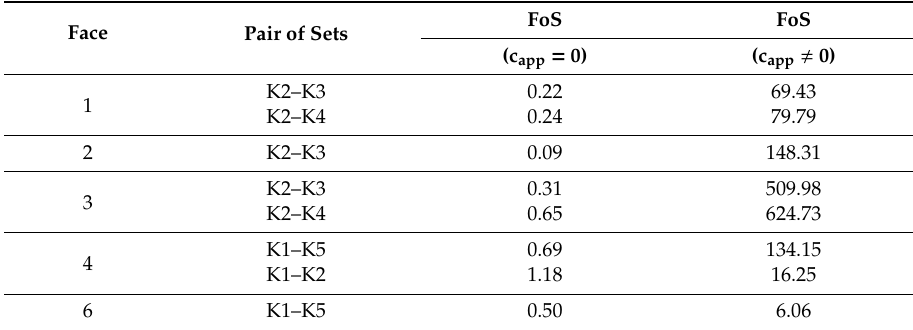
Table 10. FoS values obtained considering the presence of seismic action with respect to wedge sliding for excavation faces from 1 to 7.